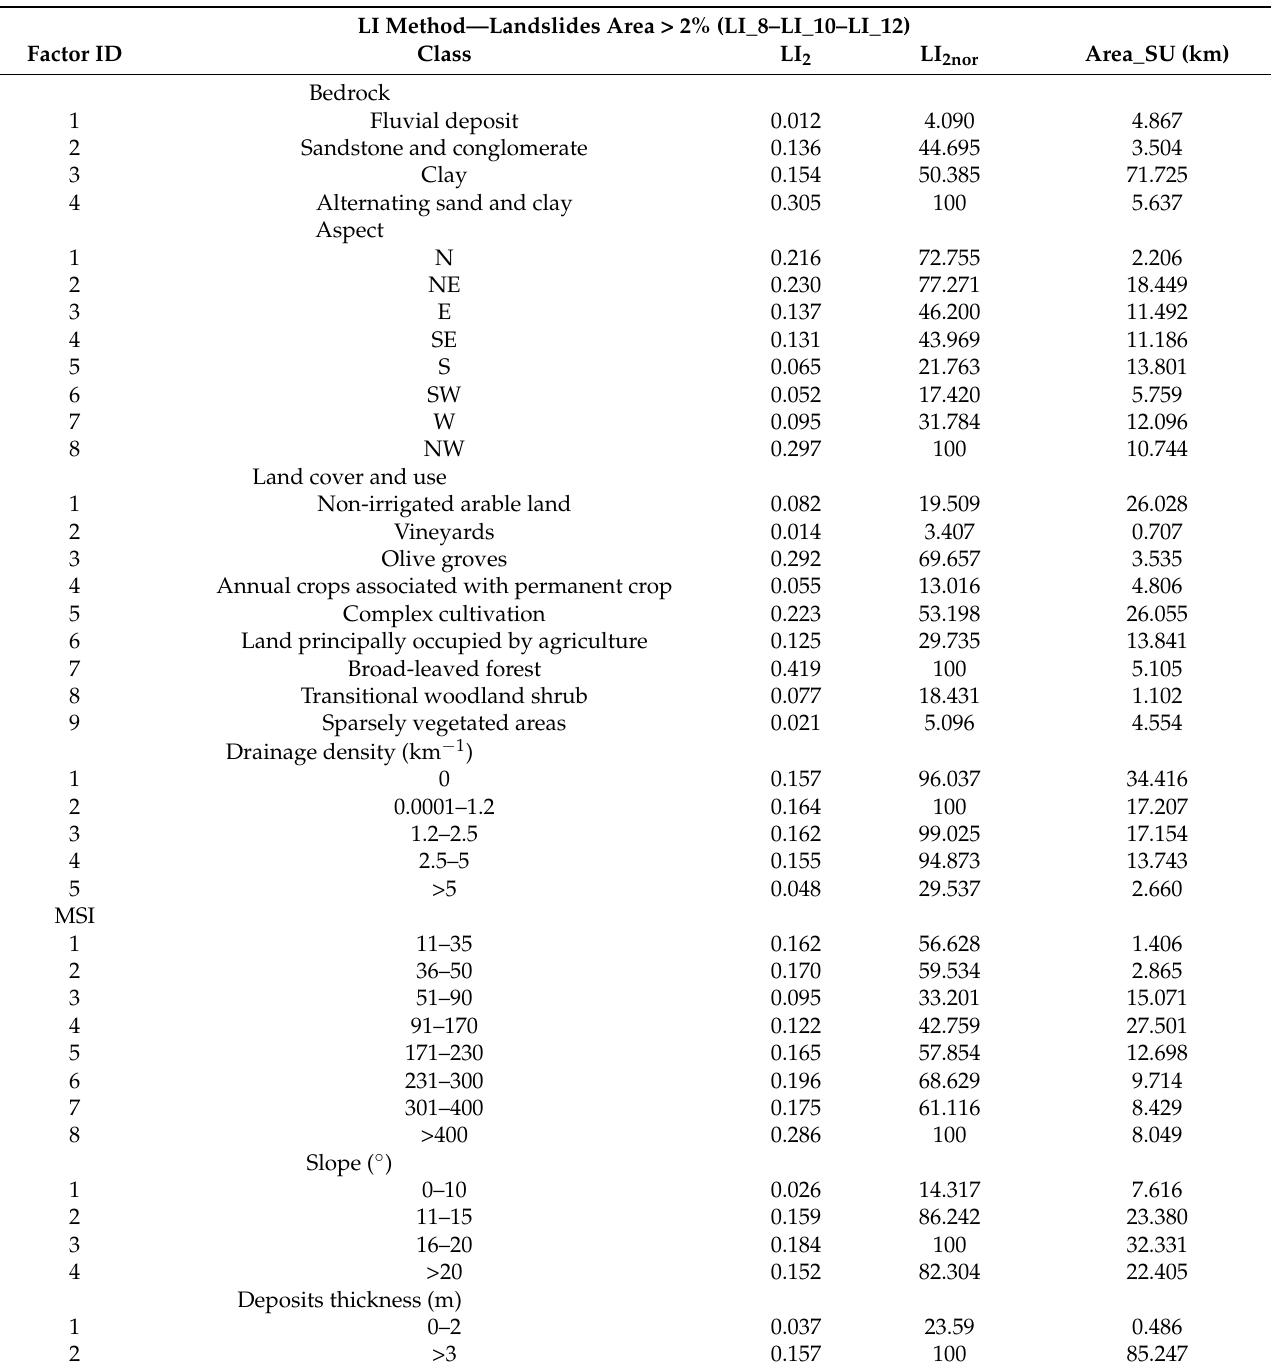
Table A6. Values of the parameters for deriving the LI for the models LI_8–LI_10–LI_12.